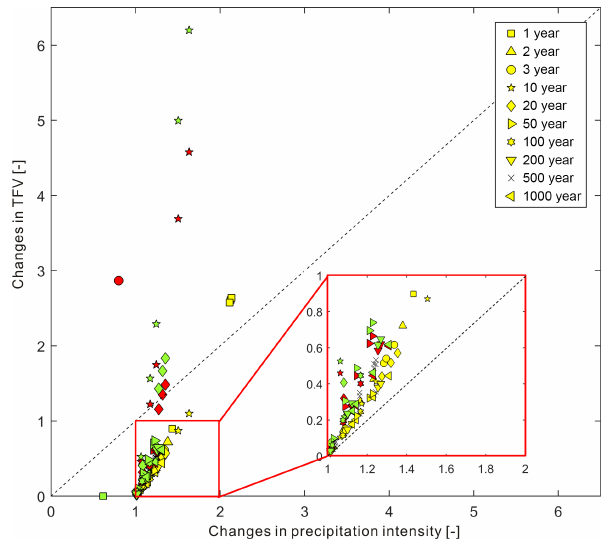
Figure 6. Future changes in flood volumes (CTFVs) relative to his- torical conditions under the current drainage system (yellow) and two adaptation scenarios (i.e. pipe in red and pipe + LID in green) at various return